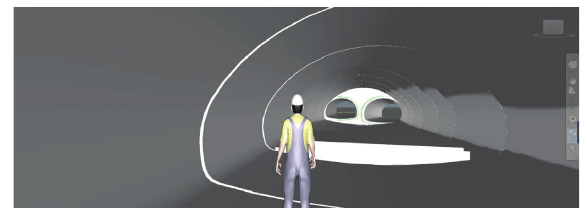
Figure 10: 3D roaming display of site